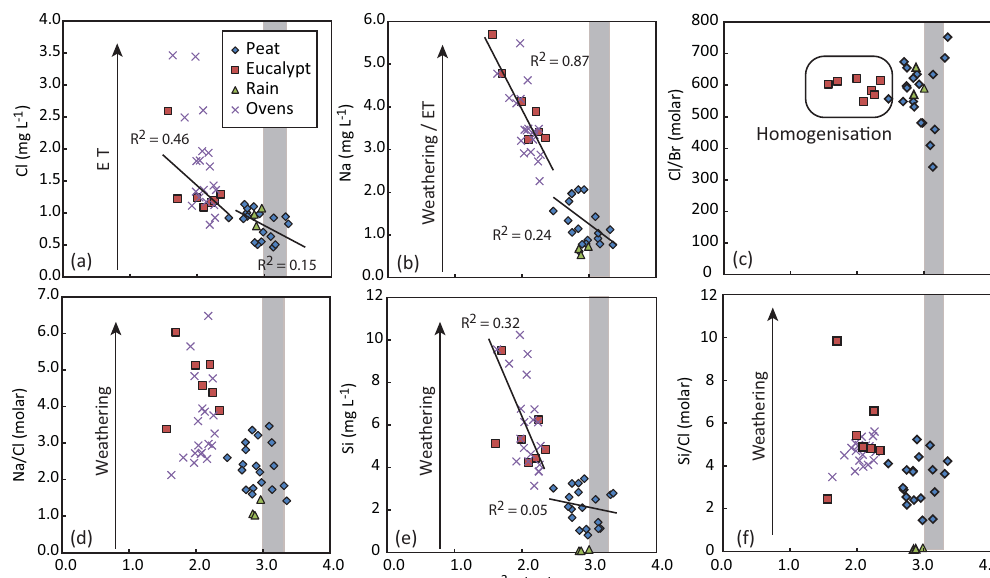
Figure 5. 3 H activities vs. Cl (a) , Na (b) , Si (e) concentrations and Cl / Br (c) , Na / Cl (d) , Si / Cl (f) ratios (data from Table 1). Arrowed lines illustrate trends expected from major geochemical processes. Ovens data are from the upper Ovens Valley streams in December 2013 and February 2014 (Cartwright and Morgenstern, 2015); the geochemistry of these larger streams is similar to the eucalypt forest streams in the Victorian